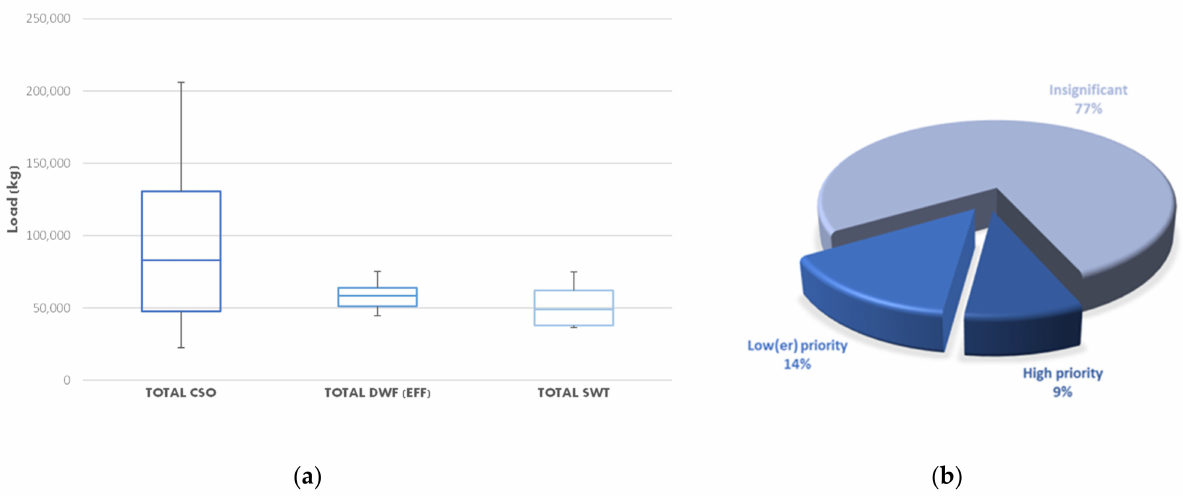
Figure 11. ( a ): Total COD emitted loads in Kortenberg catchment in 2012 for all CSOs, WWTP effluent (dry weather line), and WWTP’s stormwater tank (wet weather line). ( b ): Distribution of CSOs into priority categories.